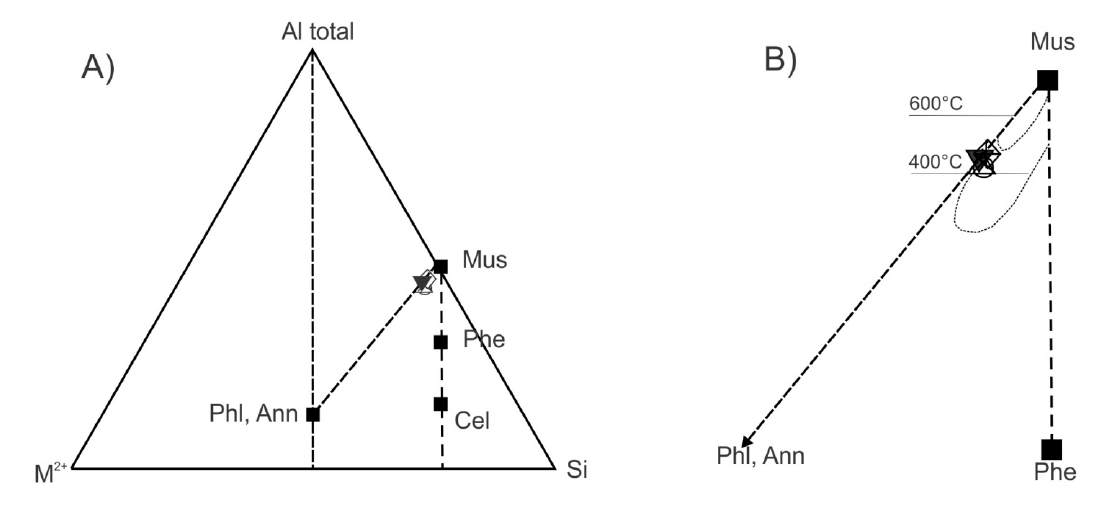
Figure 15 - ( A) Diagram Total Al-M 2 +-Si (atomic proportions) of Monier and Robert (1986) for white mica grains of the Castelo de Sonhos gold deposit (data from Appendix C), where M 2 + corresponds to divalent Fe and Mg. (B) Detail of the same diagram indicating biotite substitution